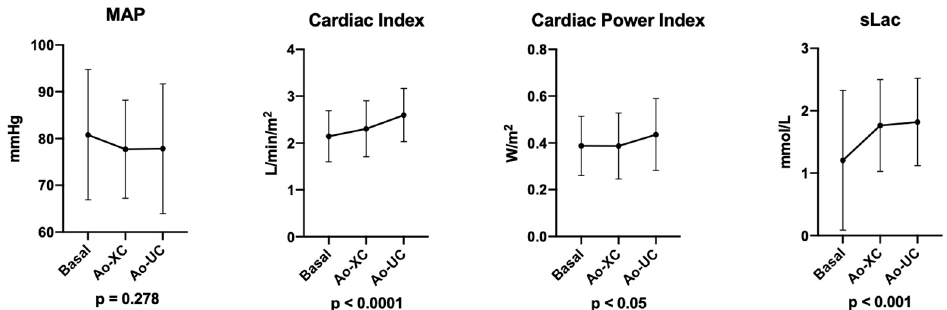
Figure 1. Intraoperative cardiovascular performance. MAP, cardiac indexm and Cardiac Power Index time-frame recordings were: basal (i.e., before the aortic clamping), Ao-XC (5 min after aortic cross-clamping), and Ao-UC (5 min after unclamping). Serum lactate concentrations were measured: basal (i.e., before aortic clamping), Ao-XC (5 min before the unclamping), and Ao-UC (15 min after the aortic unclamping). ANOVA with repeated measures was performed. Abbreviations: MAP, mean arterial pressure; sLac, serum lactate concentration; Ao-XC, aortic cross-clamping; Ao-UC, aortic